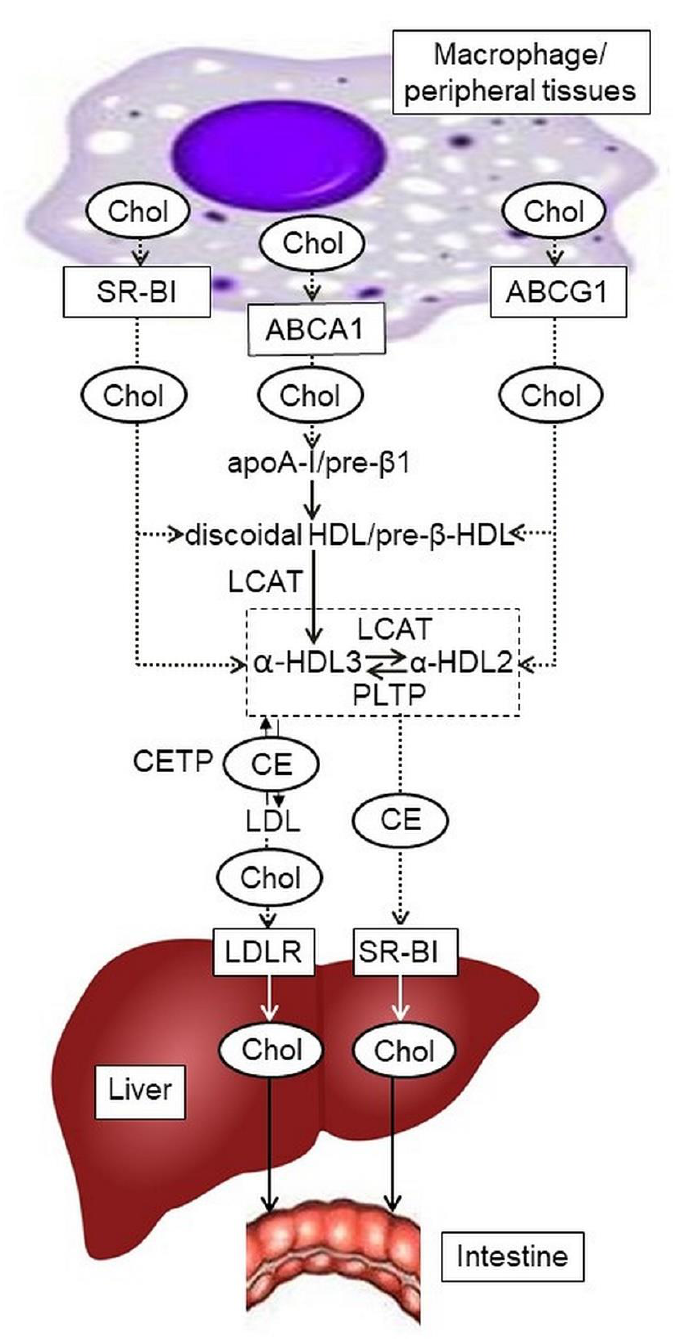
Figure 1. The major steps in the reverse cholesterol transport (RCT) pathway. RCT denotes cholesterol movement from peripheral tissue cells, macrophages in particular, to the liver. The dash arrows correspond to cholesterol transport by ABCA1, ABCG1, and SR-B1 transporters to different cholesterol acceptors and solid arrows correspond to the transitions between different lipoprotein structures. Lipid-free/lipid-poor apoA-I is an exclusive acceptor of cholesterol and phospholipid molecules exported by ABCA1, while both nascent discoidal HDL and mature spherical HDL2 and HDL3 particles accept lipid molecules exported by ABCG1 and SR-B1. The initial complex of apoA-I, with a few molecules of cholesterol and phospholipid with pre- β 1-mobility at agarose gel electrophoresis, continues to accept more cholesterol and phospholipid molecules and transforms to a discoidal HDL particle with pre- β -mobility. Discoidal HDL is an efficient substrate for cholesterol esterification catalyzed by lecithin-cholesterol acyl transferase (LCAT) with the appearance of HDL3 and